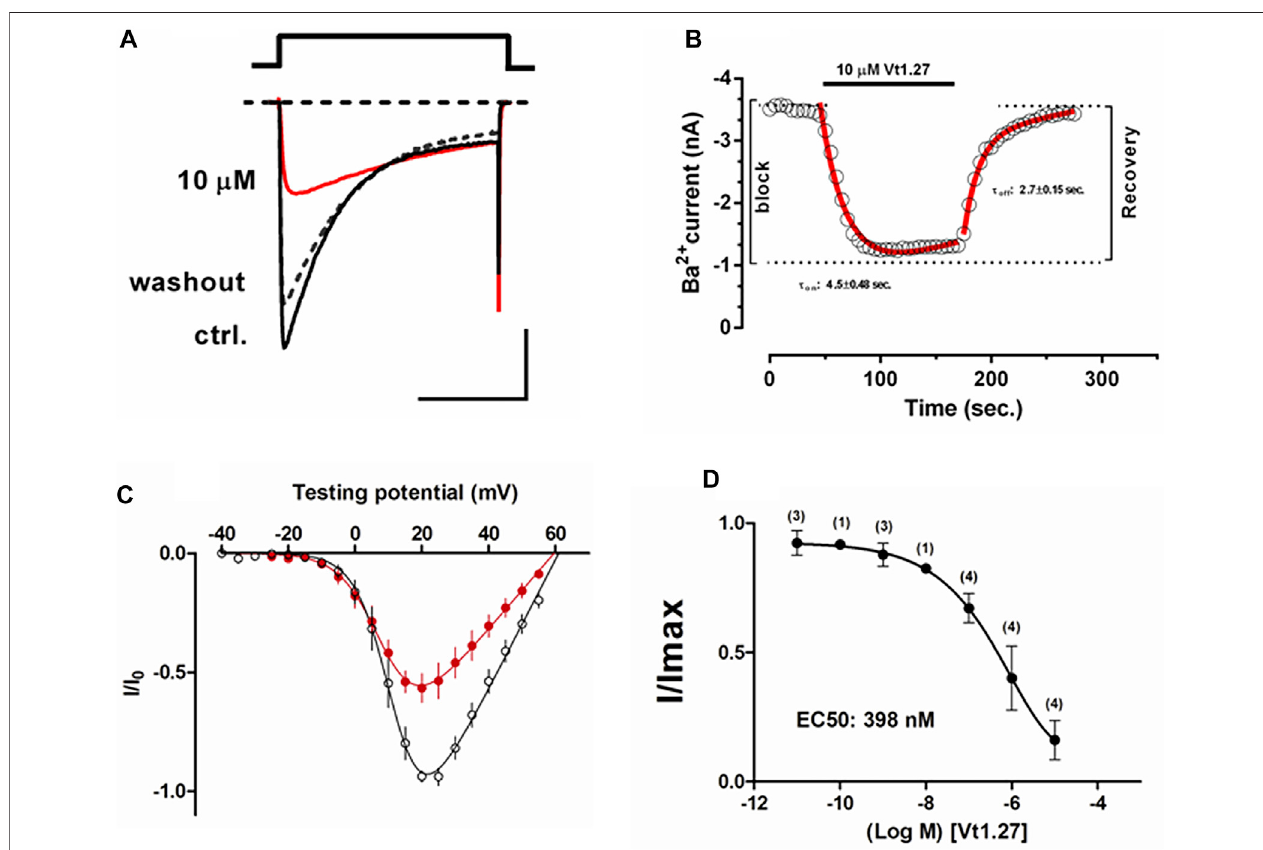
FIGURE 4 | Effects of Vt1.27 on depolarization-activated Ba 2+ currents in HEK293T cells. (A) Representative depolarization-activated whole-cell Ba 2+ currents (black).CellswerepulsedfromaholdingpotentialHPof − 80 mVfor200 msatafrequencyof0.2 HzVt1.27(10 µM)inhibitionisindicatedinred.Thedashedlinerefersto the washout of Vt1.27. Scale: 1 nA, 100 ms. (B) Representative on and off kinetics upon application of 10 µM Vt1.27. The off kinetics suggests a full recovery of the current. (C) Current-voltage (I-V) relationship obtained in the absence and presence of 1 µM Vt1.27. (D) Concentration-response relationship obtained for Vt1.27 inhibition of Ca V 2.2 (IC 50 = 398 nM). Data shown in C and D represent the mean ± SEM ( n =